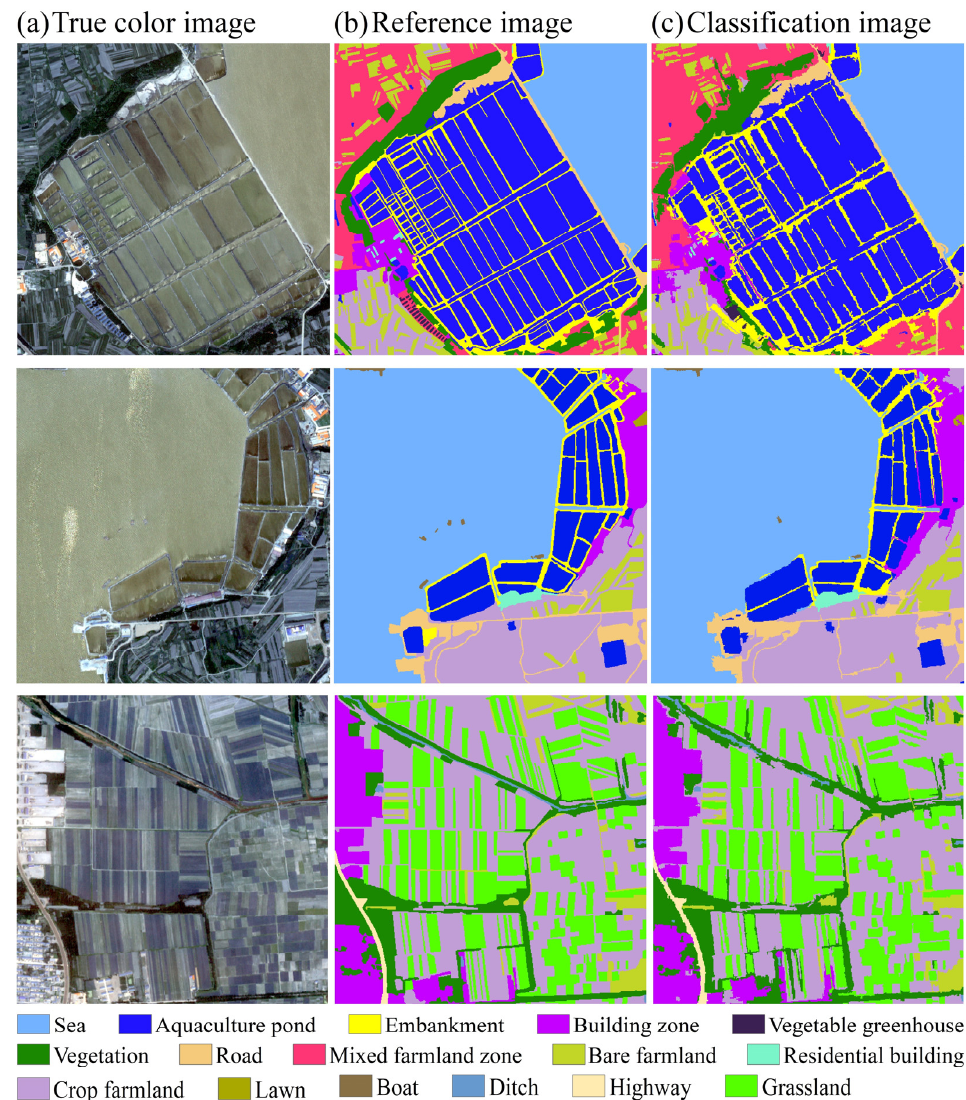
Figure 12. Comparison of the classification result and reference image. ( a ) is the true color imagery of the original HR remote sensing imagery. The background colors in ( b , c ) represent different land covers.